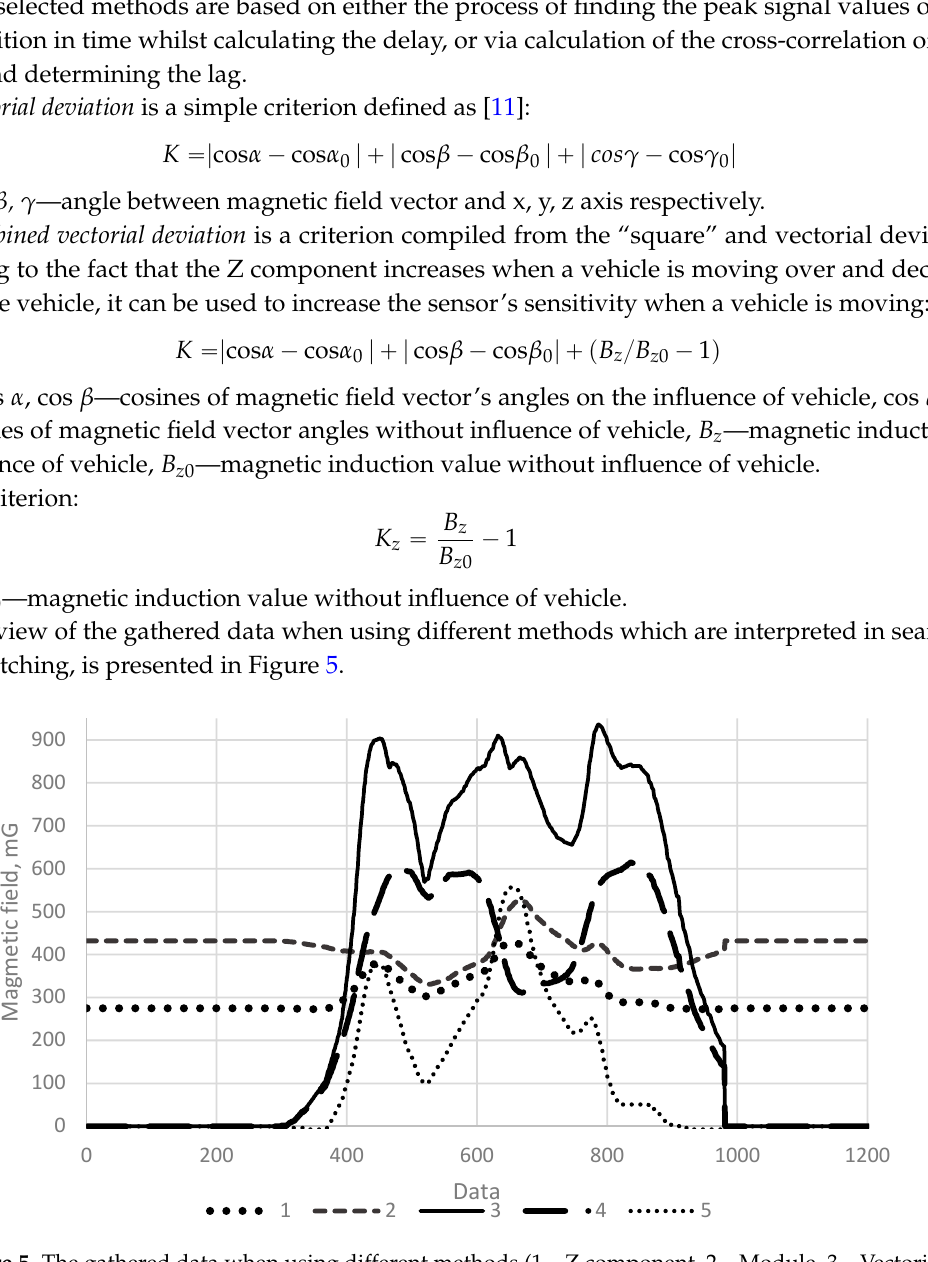
Figure 5. The gathered data when using different methods (1—Z component, 2—Module, 3—Vectorial deviation, 4—Combined vectorial deviation, 5— K z criterium).